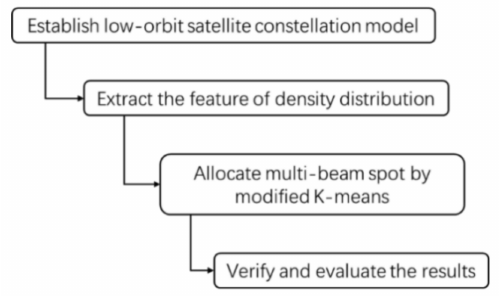
Figure 2. Flow chart of proposed